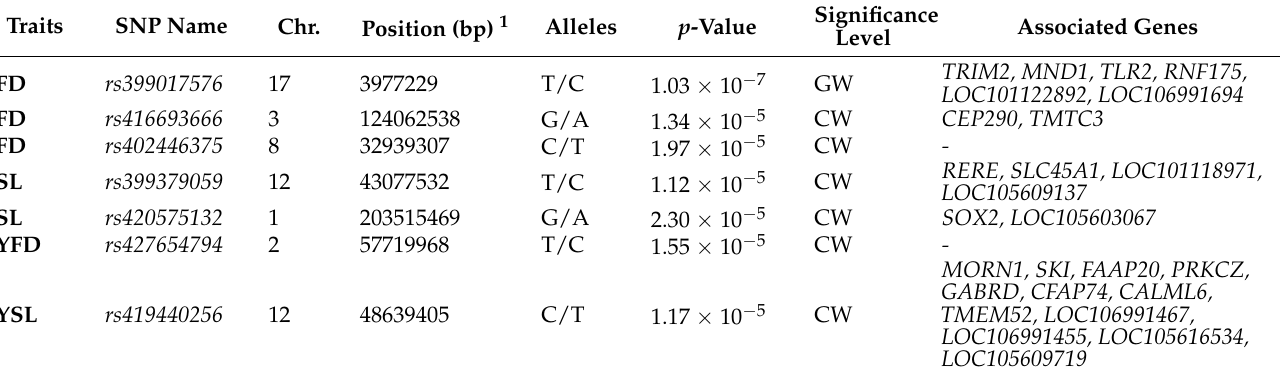
Table 3. Significant SNPs associated with wool traits.